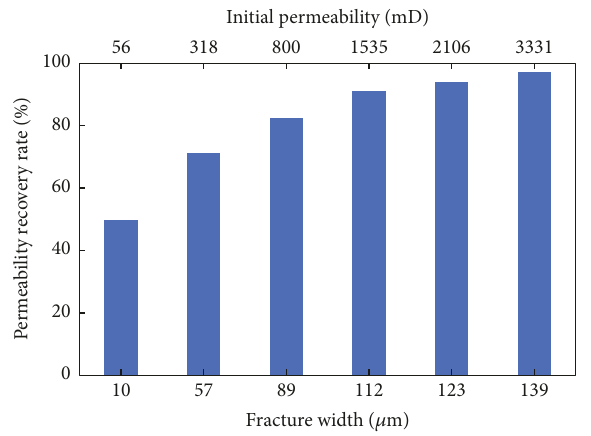
Figure 7: Permeability damage due to fracturing fluid (core samples #1–#6).